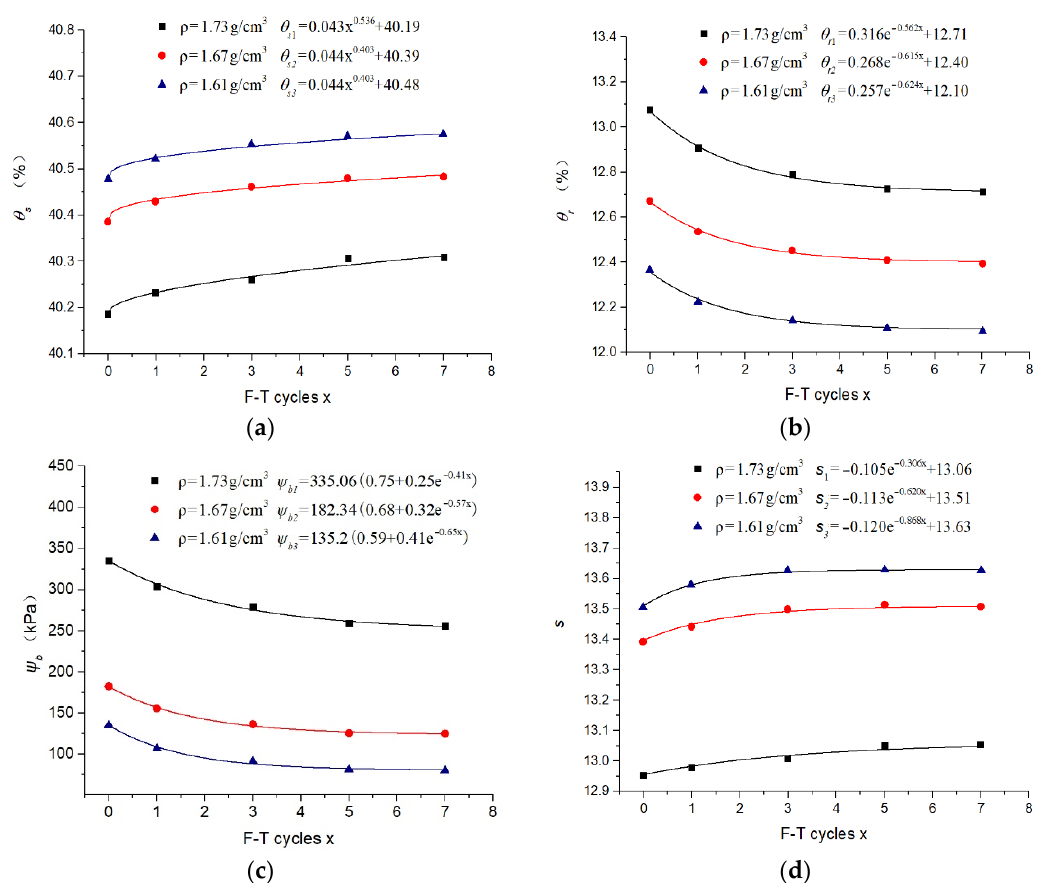
Figure 7. Fit curves of SWCC characteristic parameters and F–T cycles. ( a ) Saturated moisture con- tent and F–T cycles; ( b ) Residual moisture content and F–T cycles; ( c ) AEV and F–T cycles; ( d ) s 1 and F–T cycles.